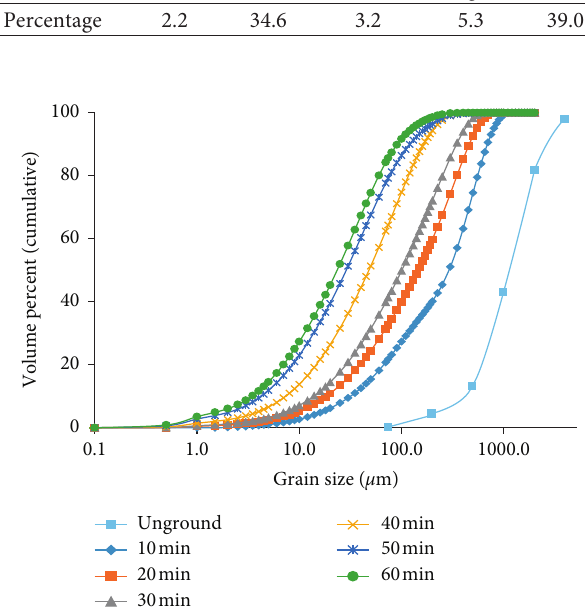
Table 1: The main chemical properties of the Cu-Ni water quenching smelting slag (wt.%). Element CaO